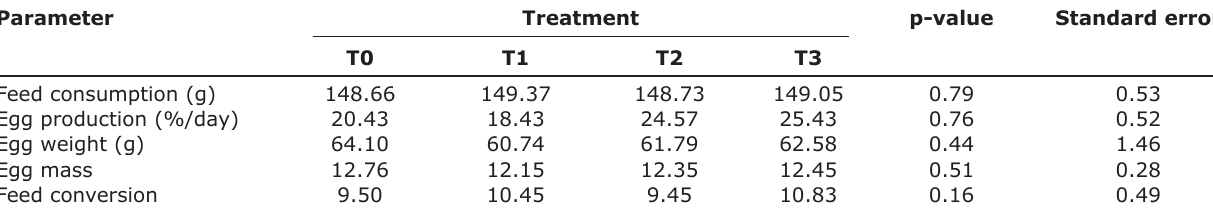
Table-2: Production performance of Pengging duck of 75-78 weeks old when added with synbiotic (inulin of gembili tuber and Lactobacillus plantarum). Parameter